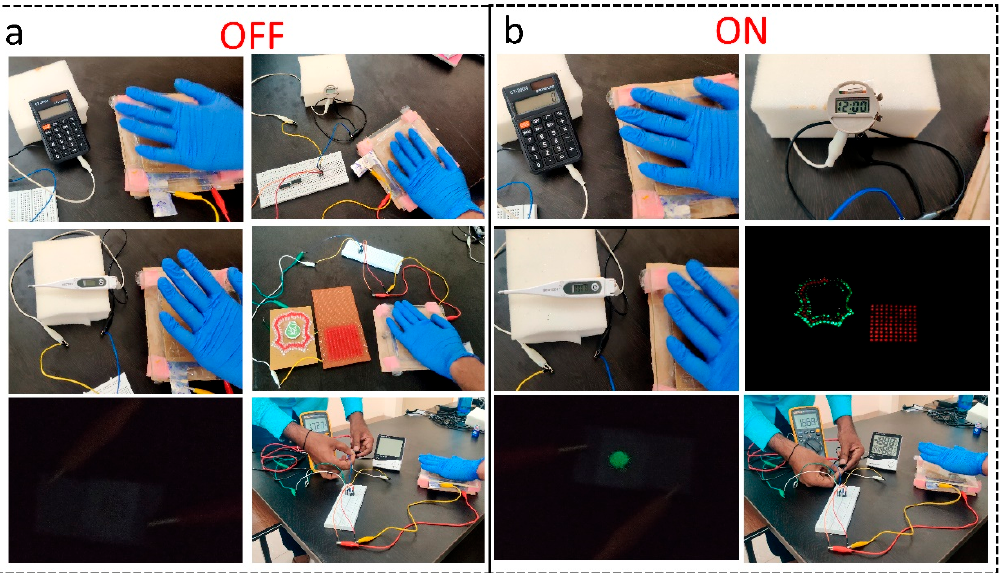
Figure 5 . Photographs of the various portable devices, EL device, and hygrometer powered with the ZIF-67-based TENG: ( a ) OFF state and ( b ) ON state .